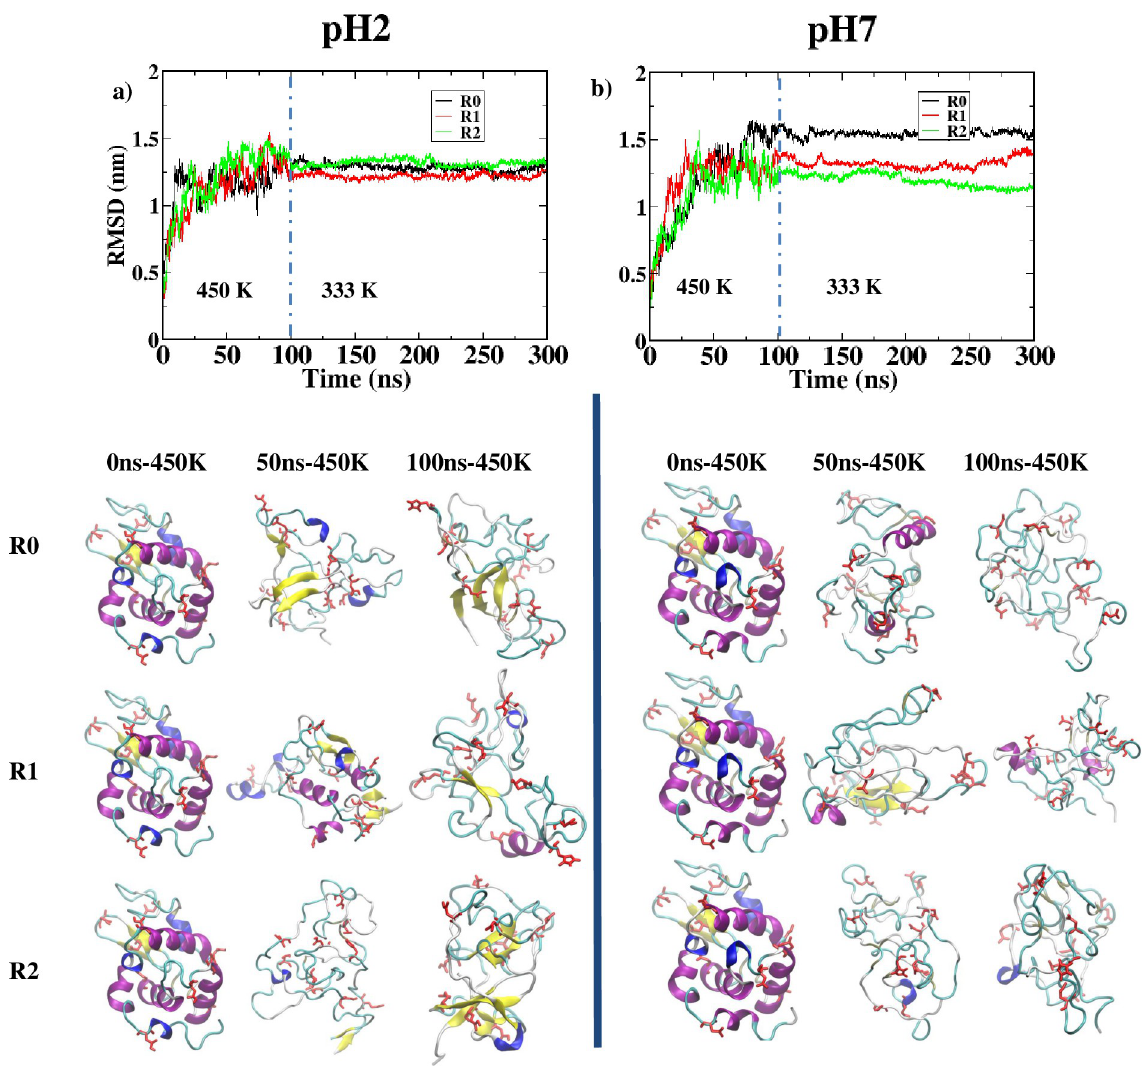
Fig 1. RMSD calculated along all three replicas of MD simulations at 450 K and 333 K–R0 (black), R1 (red), and R2 (green)—at (a) pH 2 and (b) pH 7. Vertical dashed lines represent the time t = 100 ns where the temperature was switched from 450 K to 333 K. Conformational snapshots after 0 ns, 50 ns, and 100 ns of 450 K simulations were also presented for each replica, in which alpha helices were represented in purple and beta strands were represented in